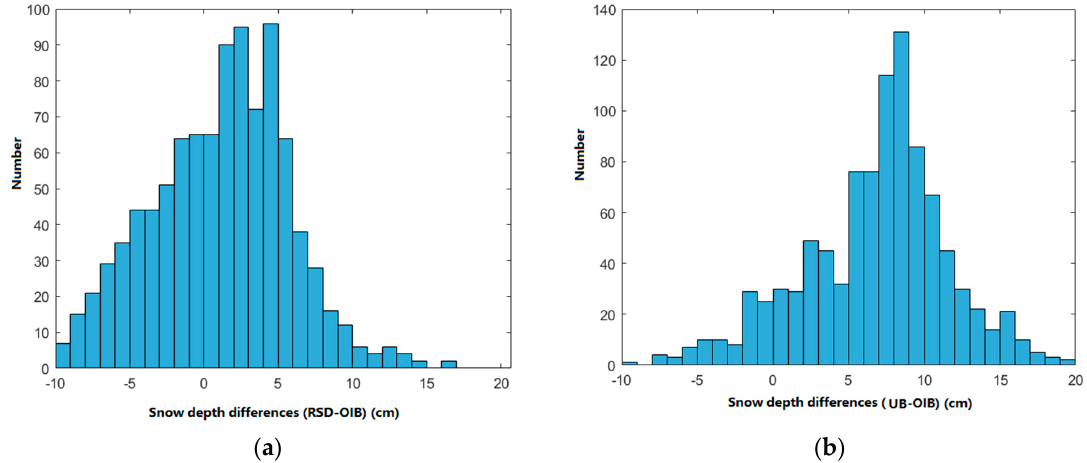
Figure 20. Difference histograms of snow depth on MYI with respect to OIB. ( a ) RSD minus OIB; ( b ) SD_UB minus OIB.